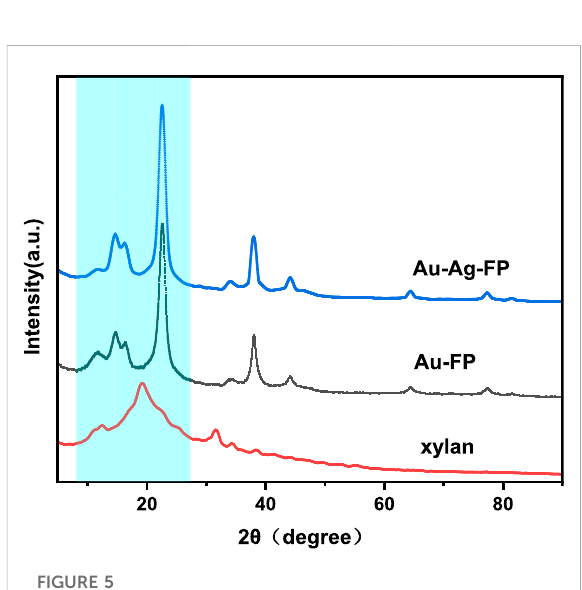
FIGURE 5 X-ray diffraction patterns of Au-Ag-FP, Au-FP and xylan.